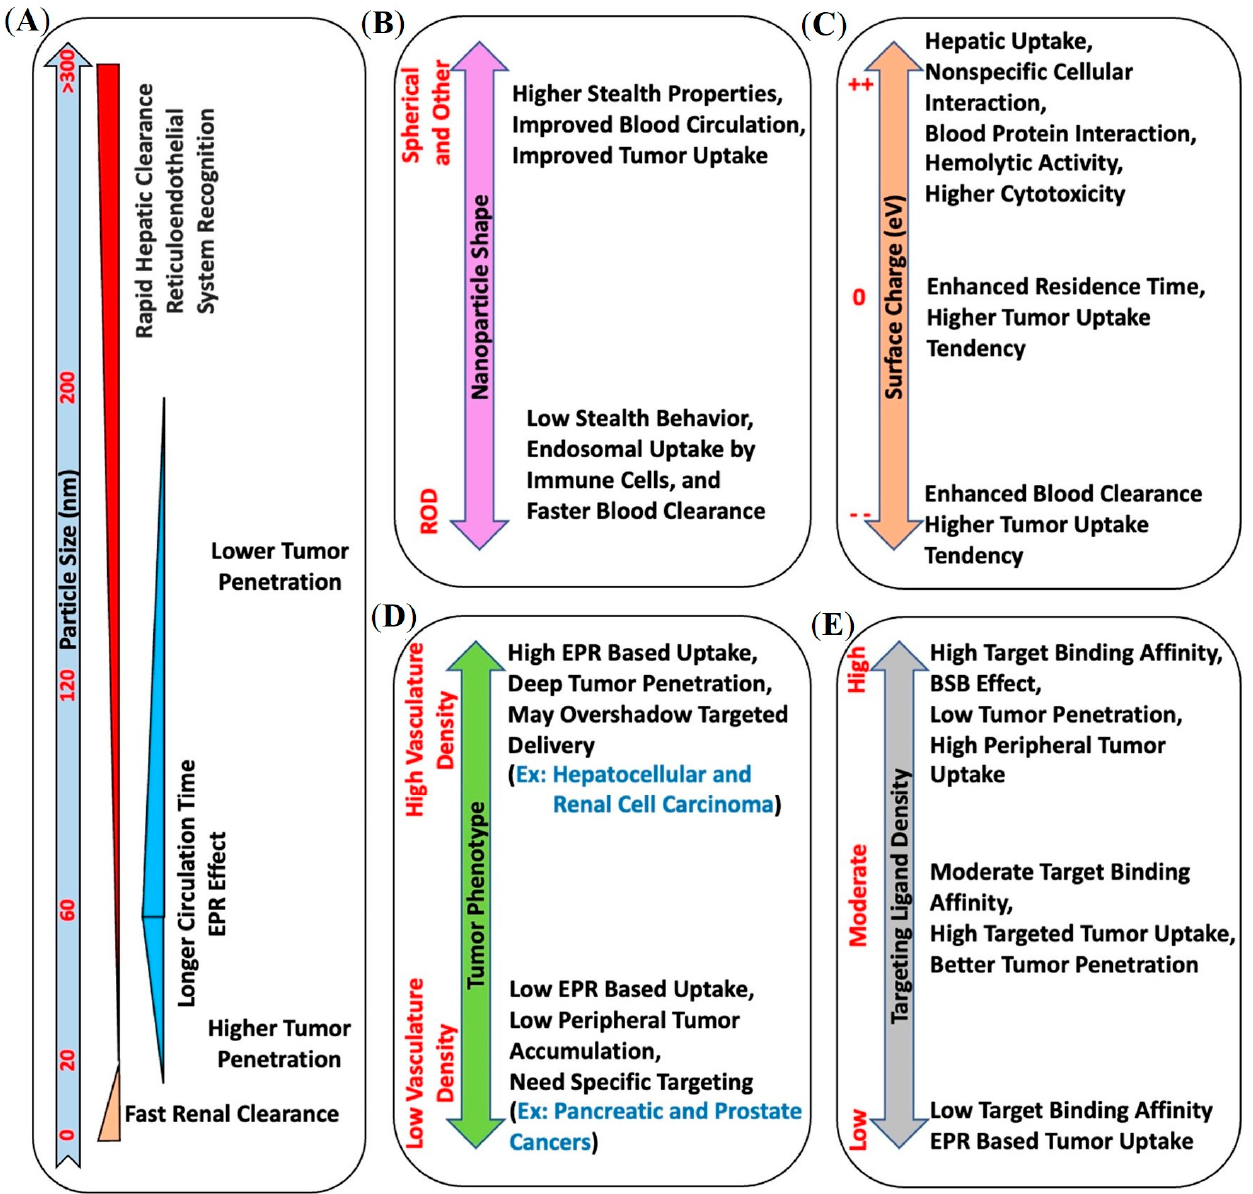
Figure 3. Summary of various physical and biological parameters associated with nanocarrier systems, like ( A ) size, ( B ) shape, ( C ) surface charge, ( D ) tumor phenotype, and ( E ) targeting ligand density, that potentially influence their in vivo pharmacokinetics and should be considered carefully when designing nanotheranostic systems.